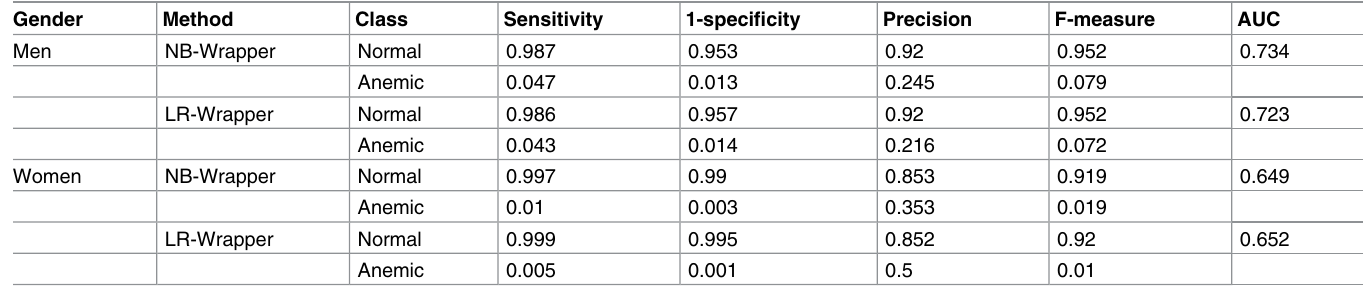
Table 4. Analysis of the predictive powers of the four models constructed using combined variables.